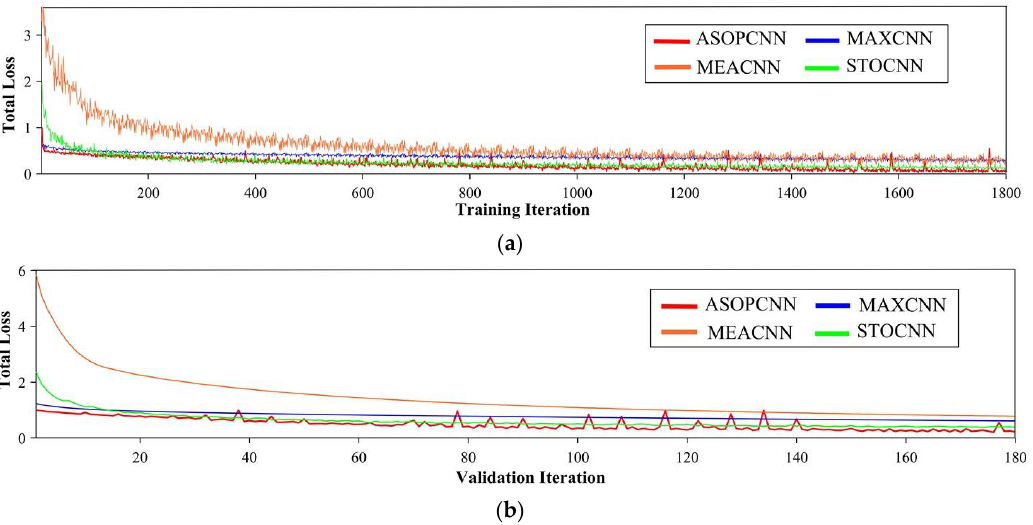
Figure 11. ( a ) The loss decline process of four models on the training set; ( b ) the loss decline process of four models on the verification set.